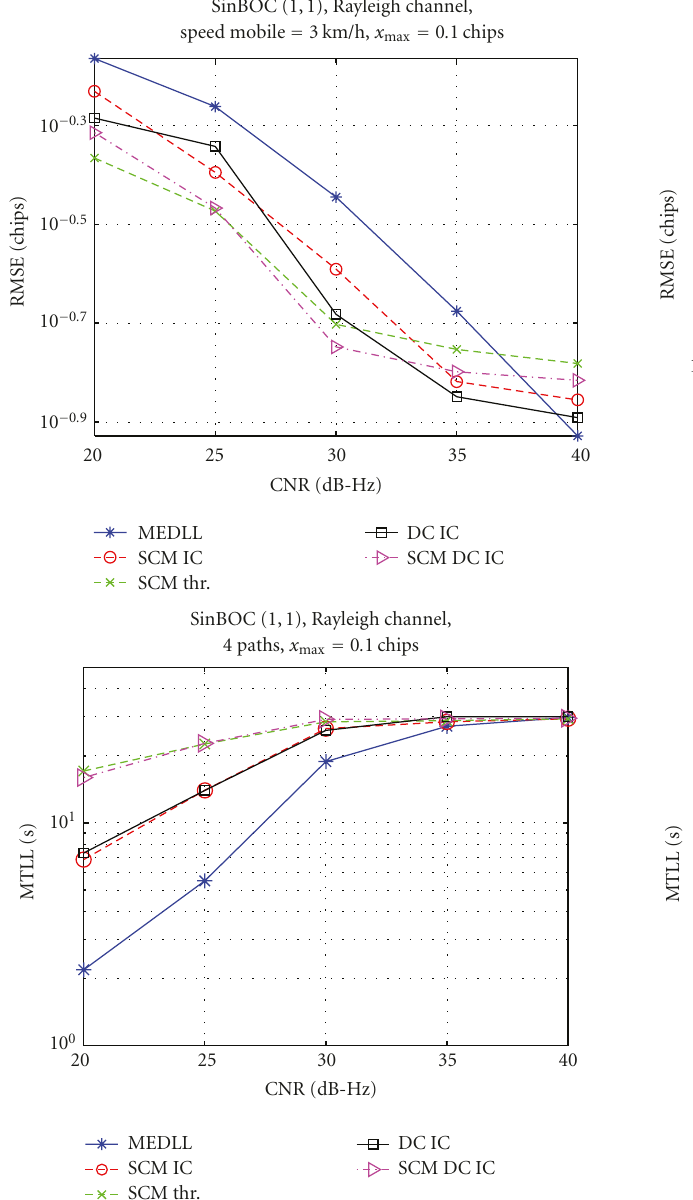
Figure 22: Comparison of feedforward delays estimation algo- rithms employing the MEDLL and IC methods and of the SCM with threshold approach, as a function of CNR; SinBOC(1,1) mod- ulation, 4-paths indoor Rayleigh channel, with PDP of − 1, − 2, 0, and − 3dB, v = 3km/h, closely spaced paths with x max = 0 . 1 chips.